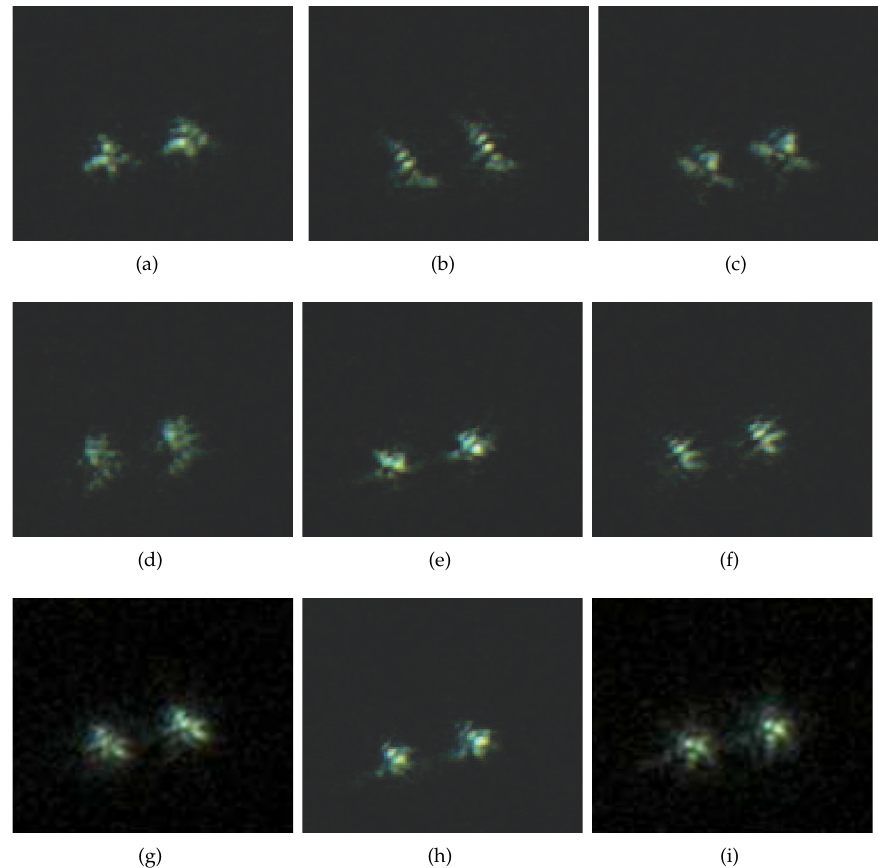
Figure 3. Nine frames of binary-star images by an AO system and their variances. ( a ) Frame 1 with = 536.34; ( b ) Frame 2 with variance S 2 = 518.06; ( c ) Frame 3 with variance S 2 = 566.23; variance S 2 2 3 1 = 495.07; ( e ) Frame 5 with variance S 2 = 552.10; ( f ) Frame 6 with variance ( d ) Frame 4 with variance S 2 5 4 = 545.26; ( g ) Frame 7 with variance S 2 = 336.34; ( h ) Frame 8 with variance S 2 = 522.95; ( i ) Frame 9 S 2 6 7 8 = with variance S 2 9